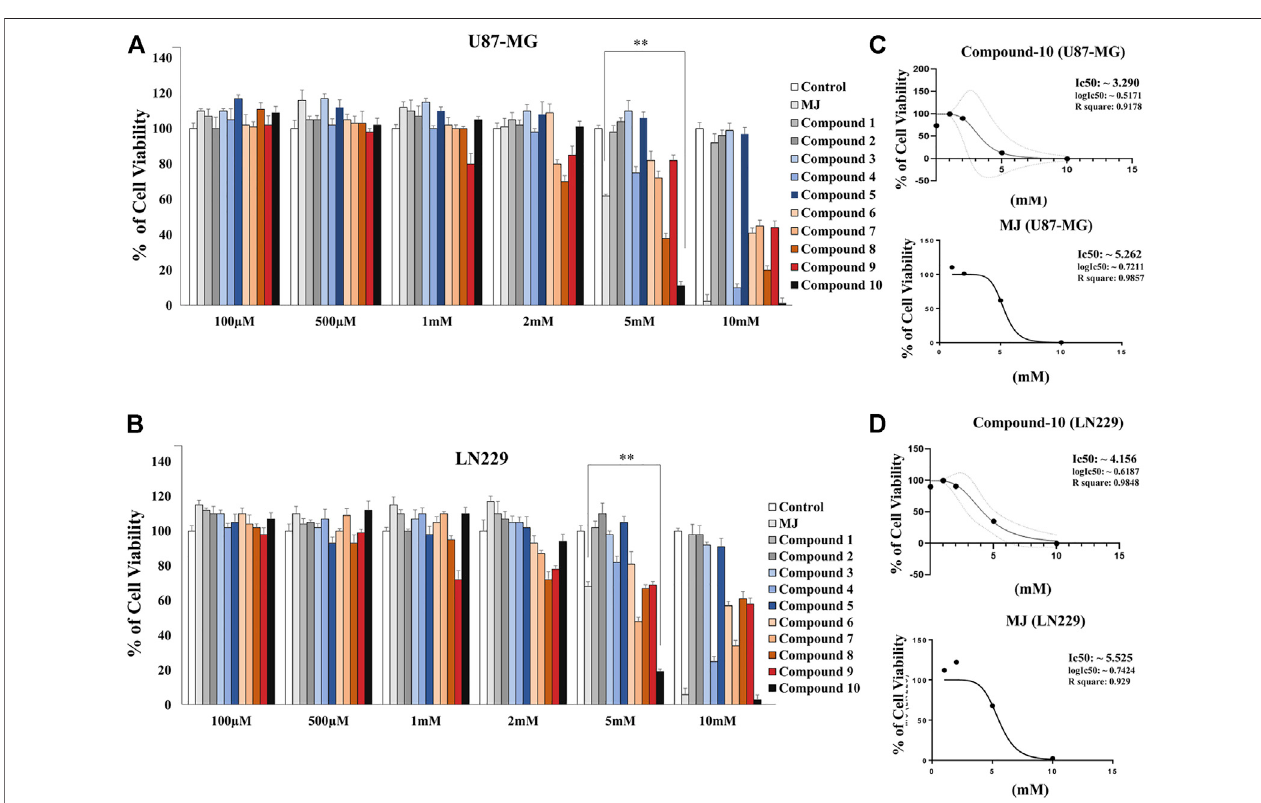
FIGURE3| ResponsetothetreatmentwithapanelofnovelMJanalogsinGBMcells.PlotshowingthepercentviabilityofU-87cells (A) andLN229cells (B) treated with10different compounds at increasingdoses (100 μ M-10 mM) for24 h. Dataare expressed asmean ±SEM.Differencesare considered signi fi cantat *p < 0.01and **p < 0.001 .DeterminationoftheIC 50 values oftheMJanalogC-10,whichisthemosteffectiveamongthe10differentcompounds compared toMJ,knownasanHK-II inhibitor, in U-87 (C) and LN229 cells (D) .